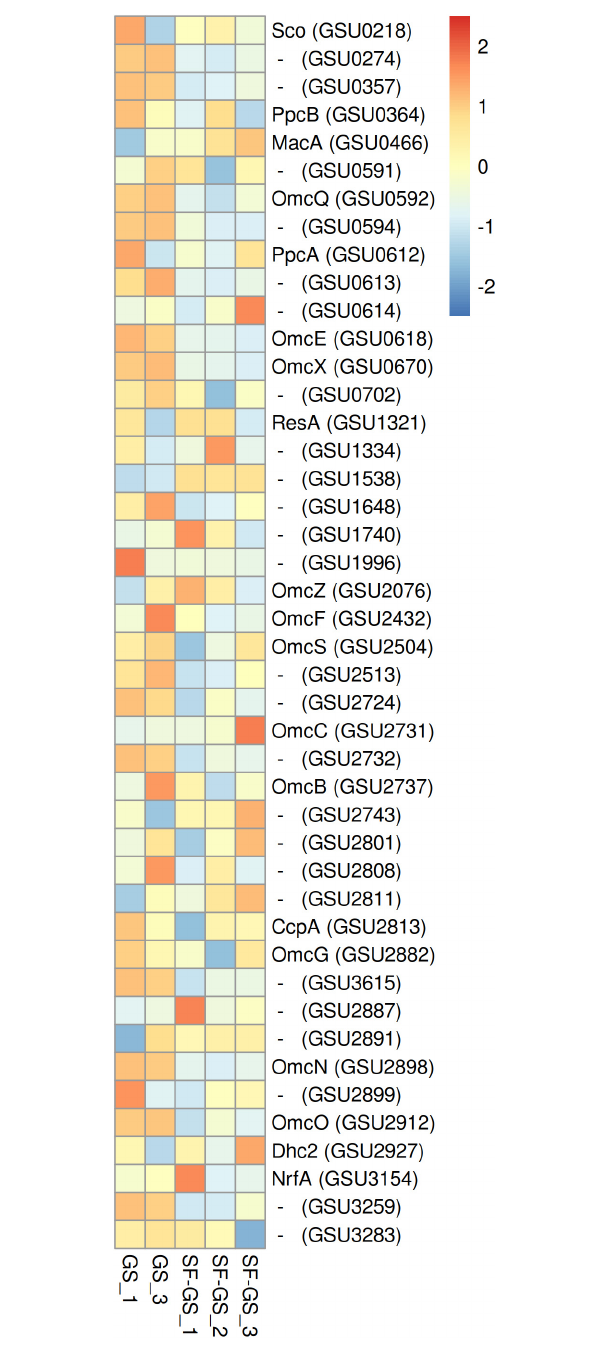
FIGURE 7 | Abundance levels of the detected C -type cytochrome of GS in the SF-GS coculture versus the GS pure culture. Protein abundance levels are shown after Z -score normalization. The color intensity indicates the degree of protein presence, where high relative abundance is indicated in red and low relative abundance in blue. The rows in the heat map show the detected proteins in the SF-GS coculture and the GS pure culture. The columns show the cultures in replicates. Protein abbreviations are as follows: cytochrome c oxidase, coo3-type, synthesis factor (Sco), cytochrome c/cytochrome b (GSU0274), cytochrome c nitrite reductase (GSU0357), cytochrome c (PpcB), (Continued)